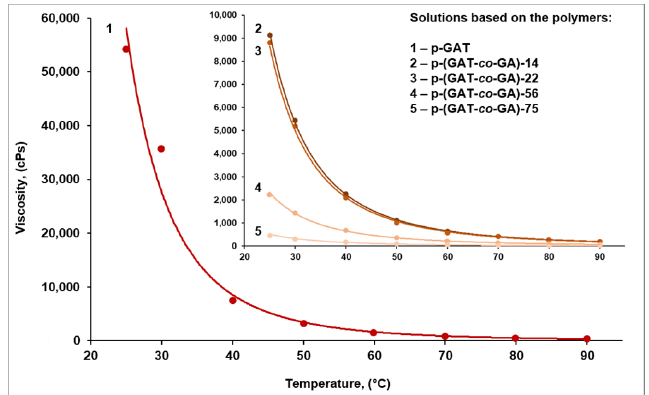
Figure 5. The viscosity of the p ‐ GAT and p ‐ (GAT ‐ co ‐ GA) solutions in the HET plasticizer plotted against temperature.